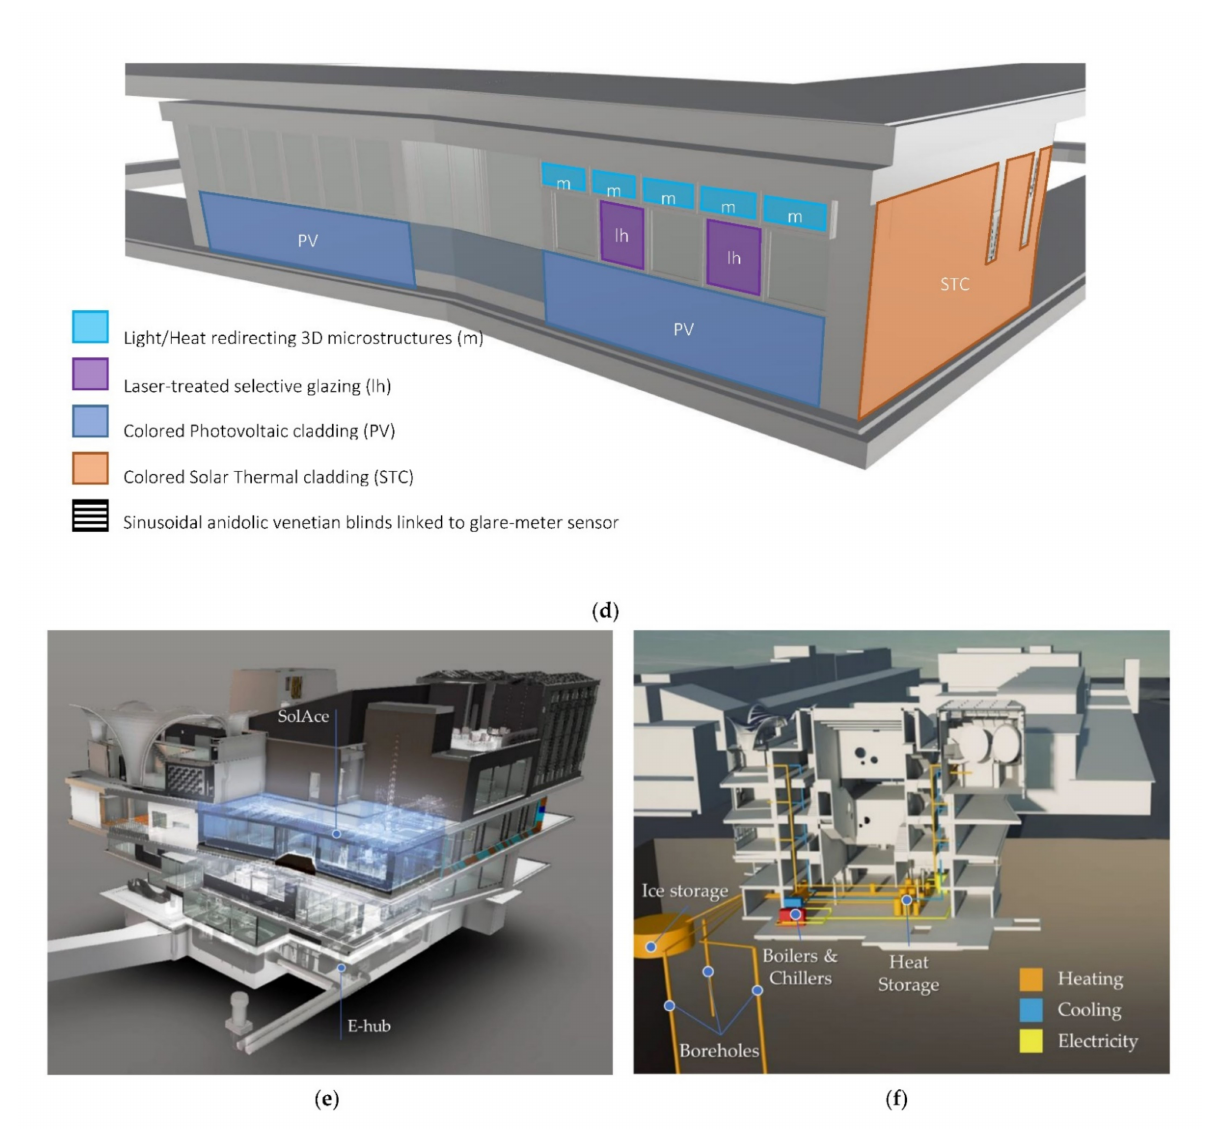
Figure 2. Plan ( a ), outdoor view ( b ), multifunctional façade representation ( c ), overview context map ( d ), and context model ( e , f ) of the NEST SolAce unit and the Energy-hub (plan—courtesy of Lutz Architectes, photo—Roman Keller©, context map—Google Earth©, context model of the NEST—Autodesk research©, and context model of the